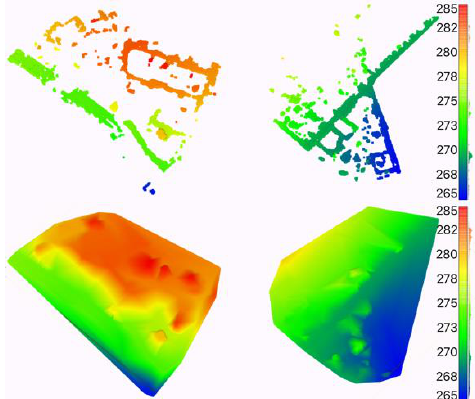
Figure 12. Extracted pre-DEM point cloud (above) and DEM (below) for evaluation set. Points are coloured with respect to their elevations: from lower (blue, green) to higher (yellow and red). The legend is in meters, representing elevation of points.